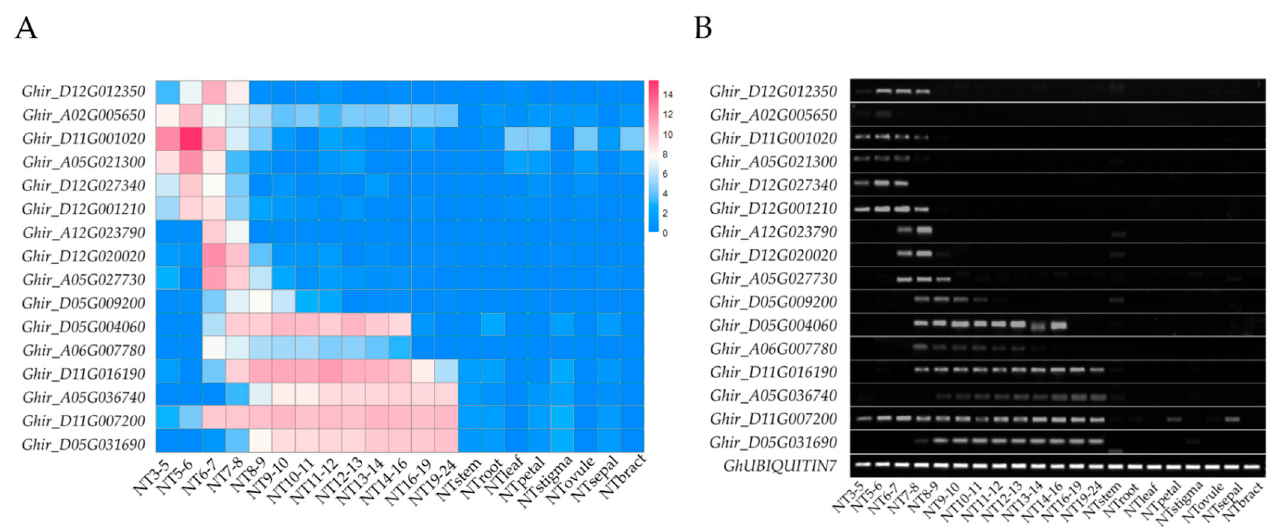
Figure 3. The expression pattern of 16 anther-specific genes (ASGs) in H05 tissues. ( A ) The expression pattern of 16 ASGs were verified by RNA-seq; ( B ) The expression pattern of 16 ASGs was verified by RT-PCR. The GhUBIQUITIN7 gene was used as a reference gene; In ( A , B ), the row names represent the gene ID of 16 ASGs, and the column names represent 21 tissues of H05.